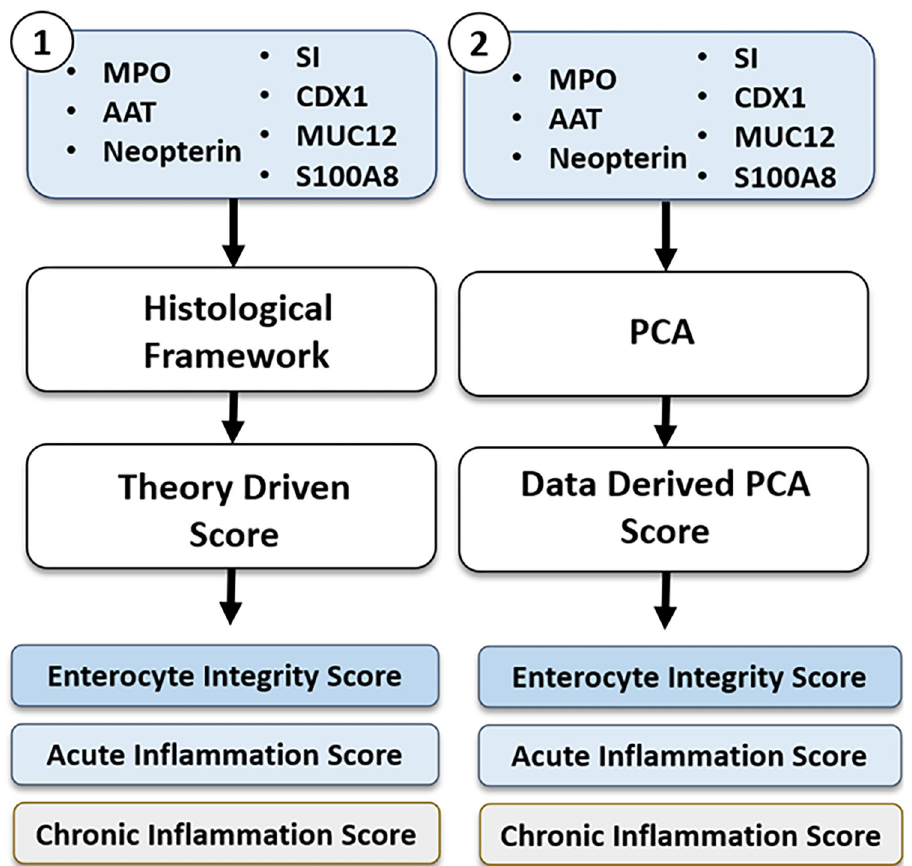
Fig 1. Derivation of the two scoring systems for the analysis. The protein biomarkers were anti-alpha trypsin (AAT), neopterin, myeloperoxidase (MPO). The mRNA biomarkers were sucrase isomaltase (SI), caudal homeobox 1 (CDX1), S100A8, and mucin